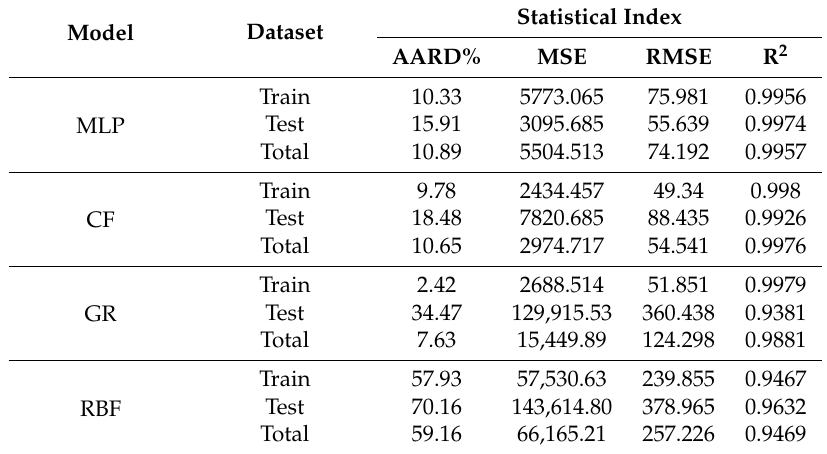
Table 8. Comparison of the statistical values for various artificial neural network (ANN) models.